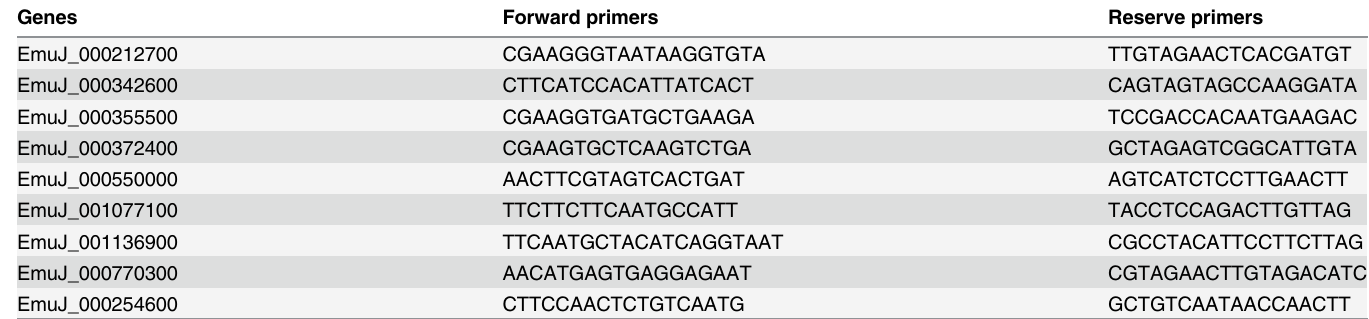
Table 1. Primers for real-time PCR.